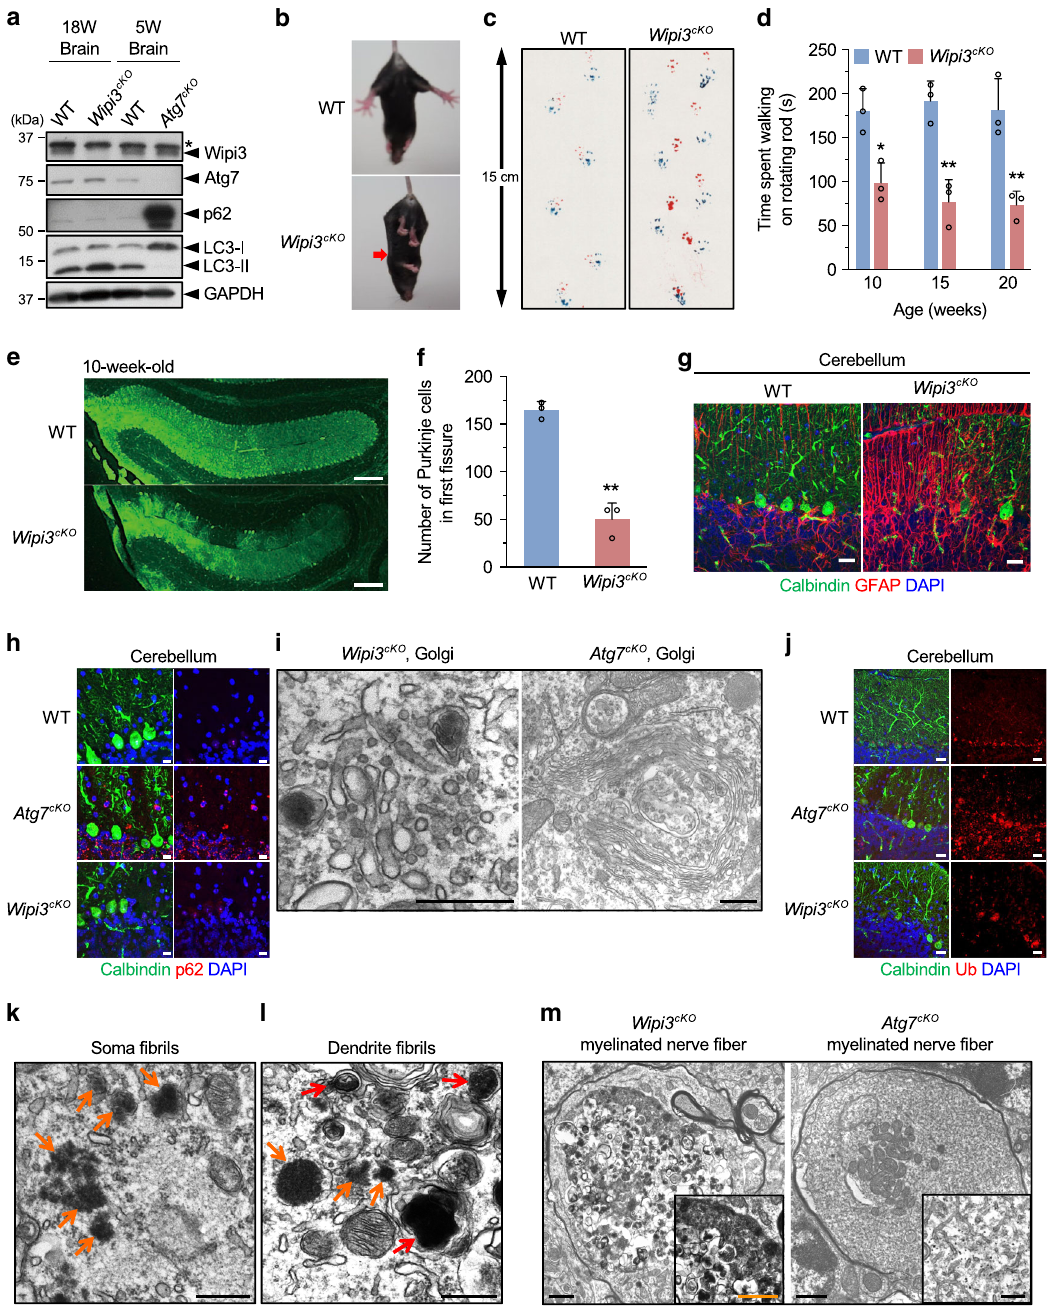
Fig. 7 Neurological defects in neuron-speci fi c Wipi3 cKO mice. a Western blot analysis of brain lysates. The asterisk indicates a nonspeci fi c band. Wipi3 cKO mice at 18-weeks were compared with Atg7 cKO mice at 5-weeks, as they showed equivalent disease severity. b – d Abnormal motor performance in Wipi3 cKO mice at 10-weeks. The limb-clasping re fl ex was observed ( b ). The footprint assay indicated a motor de fi cit ( c ). In ( d ), the time the indicated mice remained on the rod was measured. Data are shown as the mean ± SD ( n = 3). e – g Cryosections of the indicated cerebellum were immunostained for the Purkinje cell marker calbindin (green), the glial cell marker GFAP (red), and DAPI (blue). Bars = 200 µ m ( e ) and 20 µ m ( g ). In ( f ), the number of Purkinje cells in the fi rst fi ssure of the cerebellum is shown. Data are shown as the mean ± SD ( n = 3). h – m Comparisons of morphology between WT, Wipi3 cKO mice (10-weeks), and Atg7 cKO mice (5-weeks). In ( h ), cryosections of the cerebellum immunostained with anti-calbindin and anti-p62 antibodies. Bar = 10 µ m. ( i ) Morphology of Golgi in cerebella. Small fragmented and swollen rod-shaped Golgi membranes were observed in the Purkinje cells from Wipi3 cKO mice. Bars = 0.5 µ m. j Immunostaining of calbindin and ubiquitin (Ub) using cryosections of the cerebellum. Bars = 20 µ m. k , l The accumulation of fi brils was observed in Purkinje cells from Wipi3 cKO mice. Bars = 0.5 µ m. Orange and red arrows indicate naked fi brils and fi brils imperfectly enclosed by autophagy-like membranes, respectively. ( m ) Myelinated nerve fi bers of Atg7 cKO cerebella and Wipi3 cKO cerebella were fi lled with smooth ER and dense fi brils, respectively; bars = 1 µ m ( Wipi3 cKO ) and 0.5 µ m ( Atg7 cKO ). Magni fi ed images are shown in the inset; bars = 1 µ m ( Wipi3 cKO ) and 0.2 µ m ( Atg7 cKO ). In ( c ), comparisons were performed using one-way ANOVA followed by the Tukey post hoc test. * p < 0.05 and ** p < 0.01 (10, 15, 20 weeks: p = 0.0175, 0.0013, 0.0021, respectively.) In ( f ), comparisons were performed using unpaired two-tailed Student t -tests. ** p < 0.01 ( p = 0.0005). Source data are provided as a Source Data fi